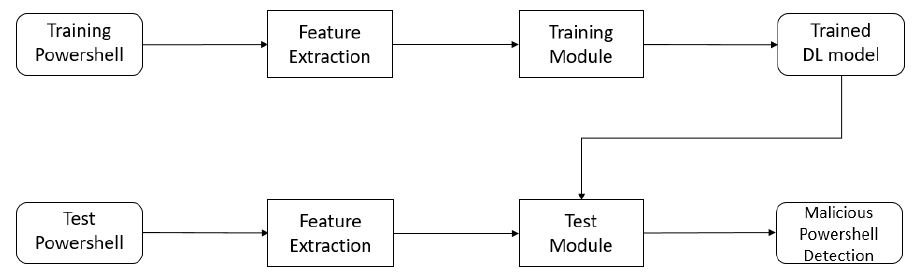
Figure 2. Deep Learning-based Malicious PowerShell Detection System.